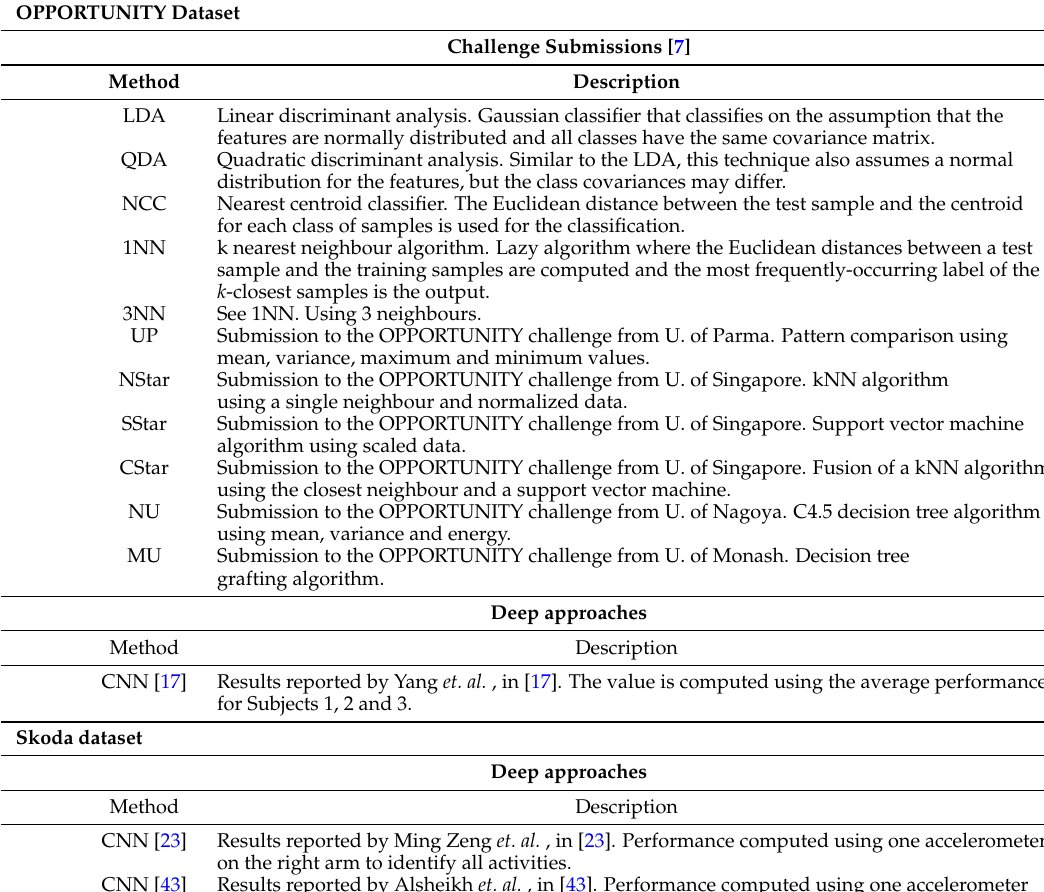
Table 3. Baseline classifiers included in the datasets’ comparative evaluation.